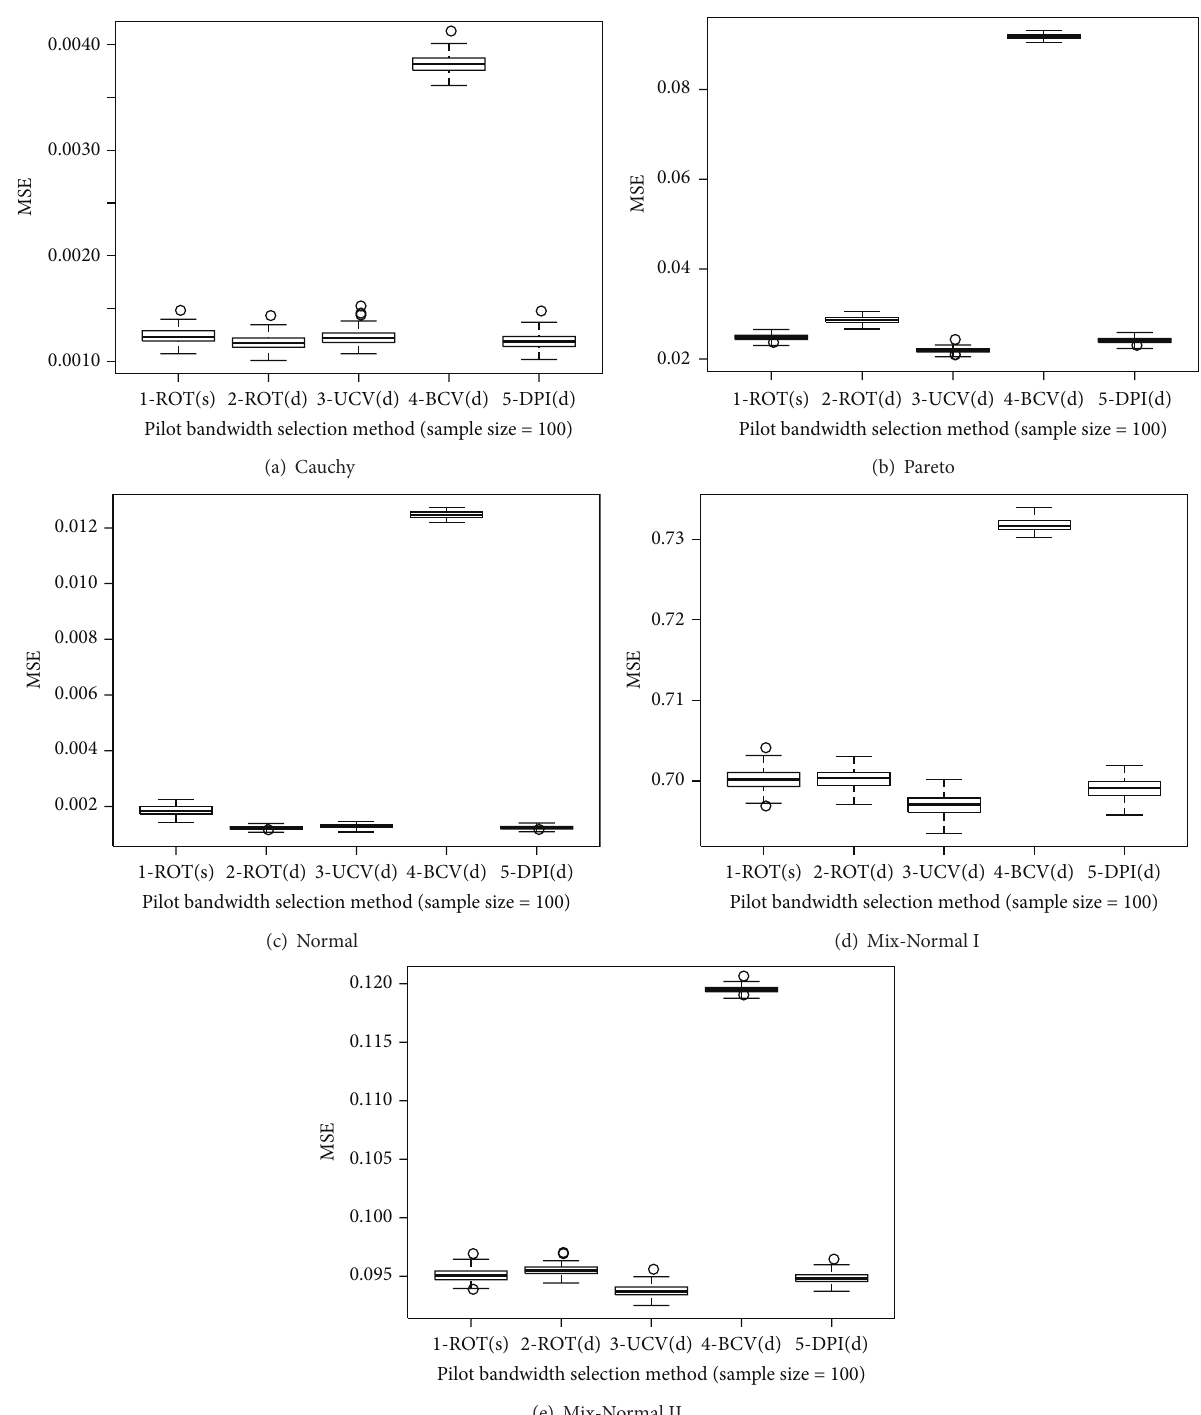
̂𝑈 1 in terms of the choice of pilot bandwidth ; “4-BCV(d)” means ̂𝑔 LSCV ; density